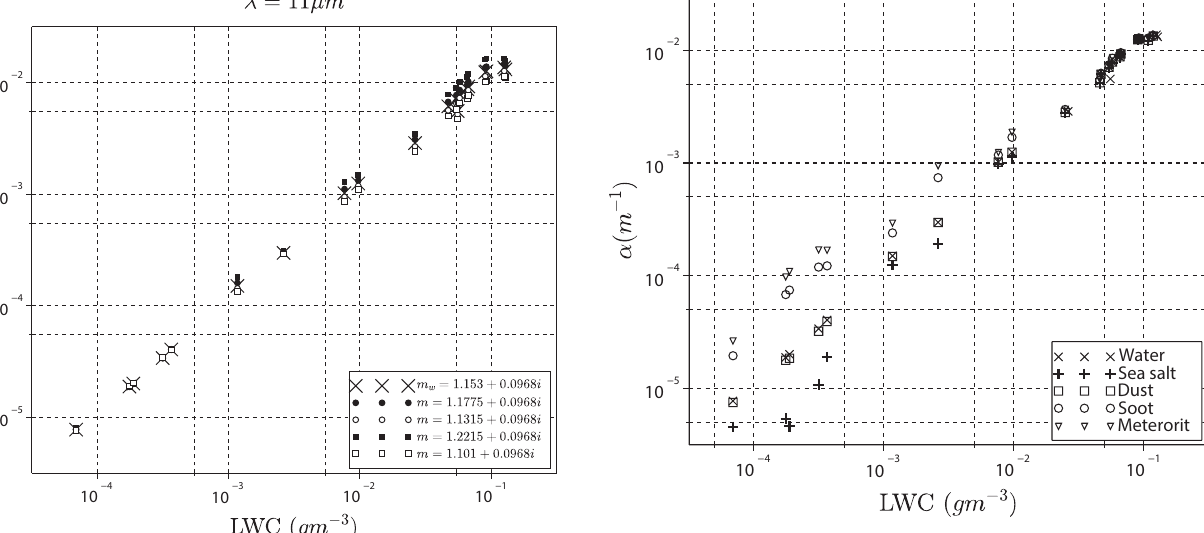
Fig. 13. Extinction coefficient versus liquid water content for the 20 fog cases studied and a refractive index of one particular aerosol type for particles with radii < 1µm and pure water above (see Eq. (10)). Four different aerosol types are considered: sea salt ( + ) , dust (square), soot (circles) and meteoric particles (triangles). For each type, the refractive index is taken from Fenn et al., 1985 (see Table 2). The extinction coefficients for a refractive index of pure water for all particle radii are given for comparison with ×